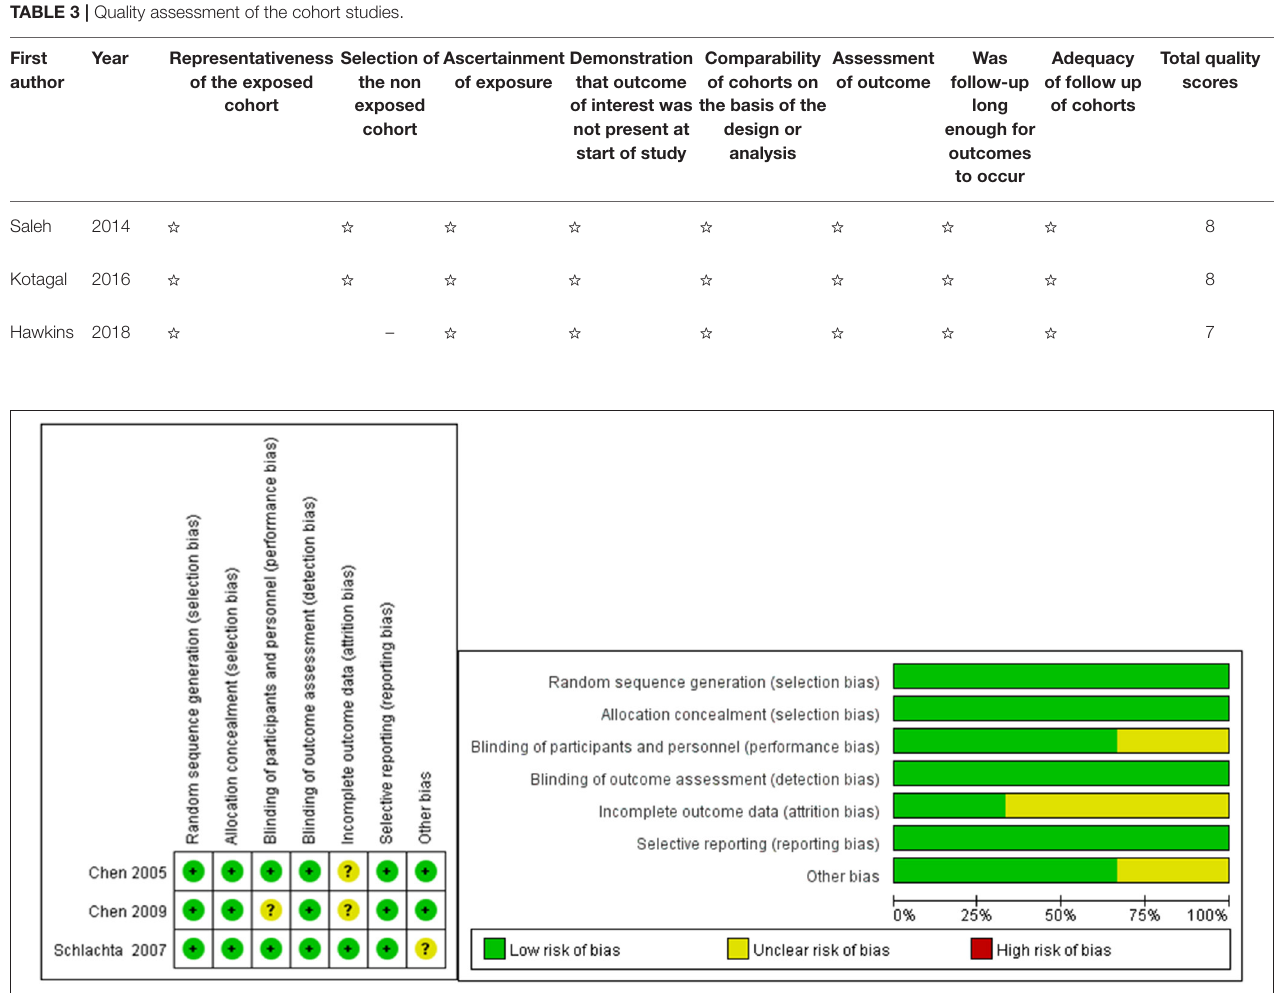
TABLE 3 | Quality assessment of the cohort studies.